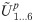
IC-based sequence divergences in the S1A protein family.The panels show scatterplots of sequences in the G protein alignment along dimensions (U˜1…6p) that correspond to sequence variation in positions contributing to each of the top six ICs of the SCA coevolution matrix. The mapping between positional coevolution to sequence relationships is achieved using the reduced alignment matrix x, as per Eqs (14) and (15). Sequences are colored either by enzymatic activity (A-C, the haptoglobins are non-catalytic members of the S1A family), annotated catalytic specificity (D-F), or taxonomic origin (G-I). For each graph, the stacked histograms show the distributions of these classifications for each dimension. Note that trypsin, tryptase, kallikreins, and certain granzymes have tryptic specificity, and chymotrypsin and most granzymes have chymotryptic specificity. The data show that IC1 specifically separates sequences by enzymatic activity (A), IC2 separates sequences by catalytic specificity (D), IC3 separates sequences by invertebrate/vertebrate origin (H), and ICs 4–6 show more minor variations by catalytic specificity (E-F). These data (1) recapitulate and extend previous observations [10], and (2) demonstrate the functional relevance of the IC-based decomposition.